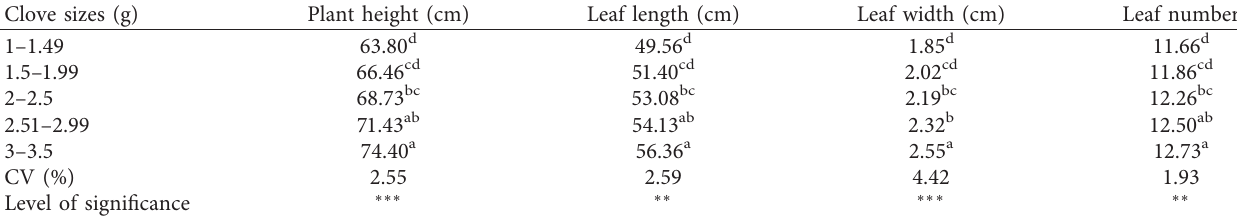
Table 2: Effect of clove sizes on plant height, leaf length, width, and